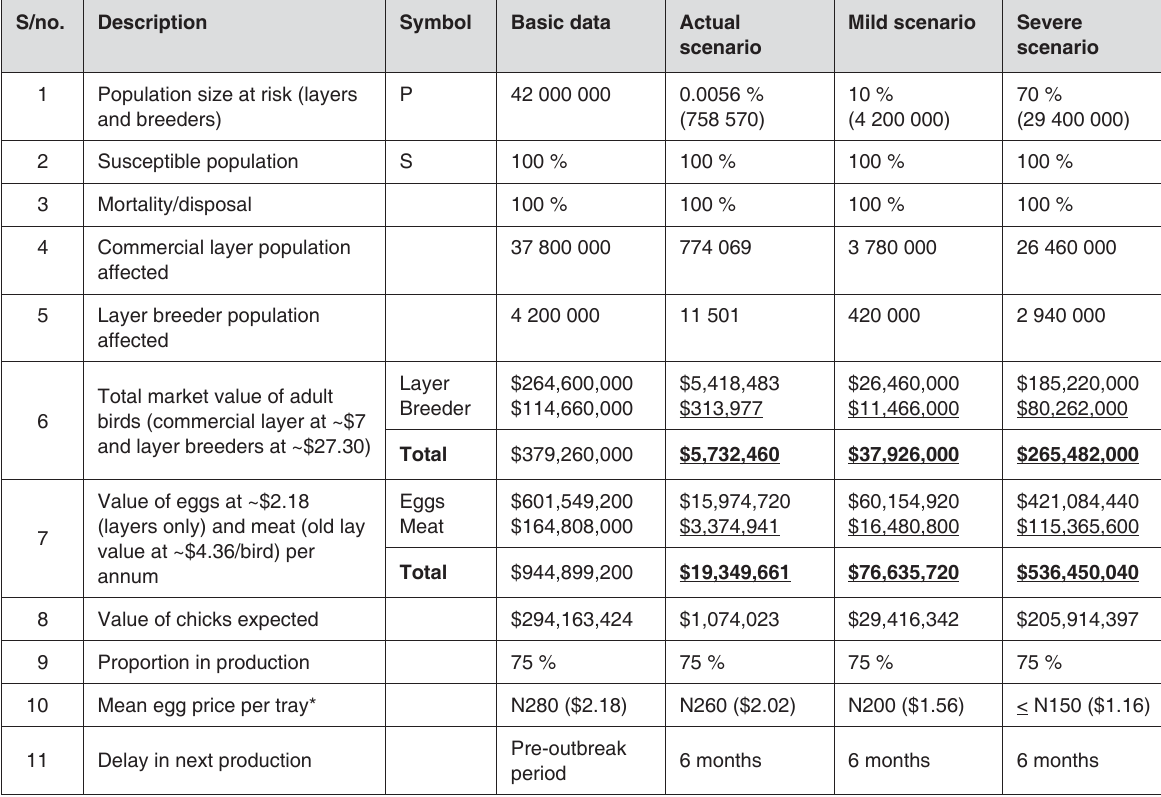
TABLE 2 Parameters used in assessing the economic impacts